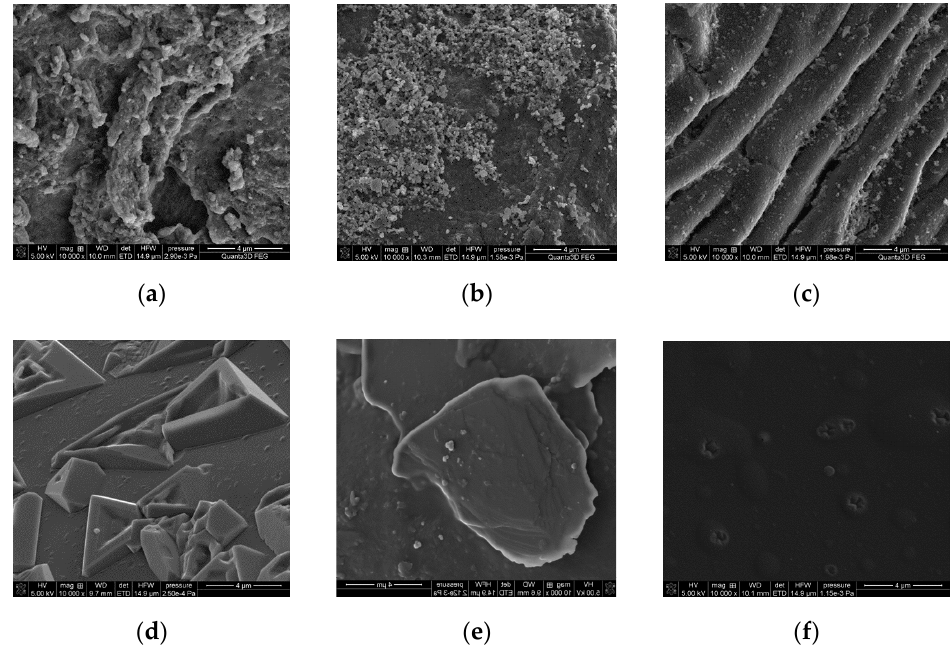
Figure 5. SEM scans of ( a ) THA, ( b ) ZH and ( c ) THA before the sorption process; after the sorption process of the Cu(II) complex with EDDS: ( d ) THA, ( e ) ZH and ( f ) THA.